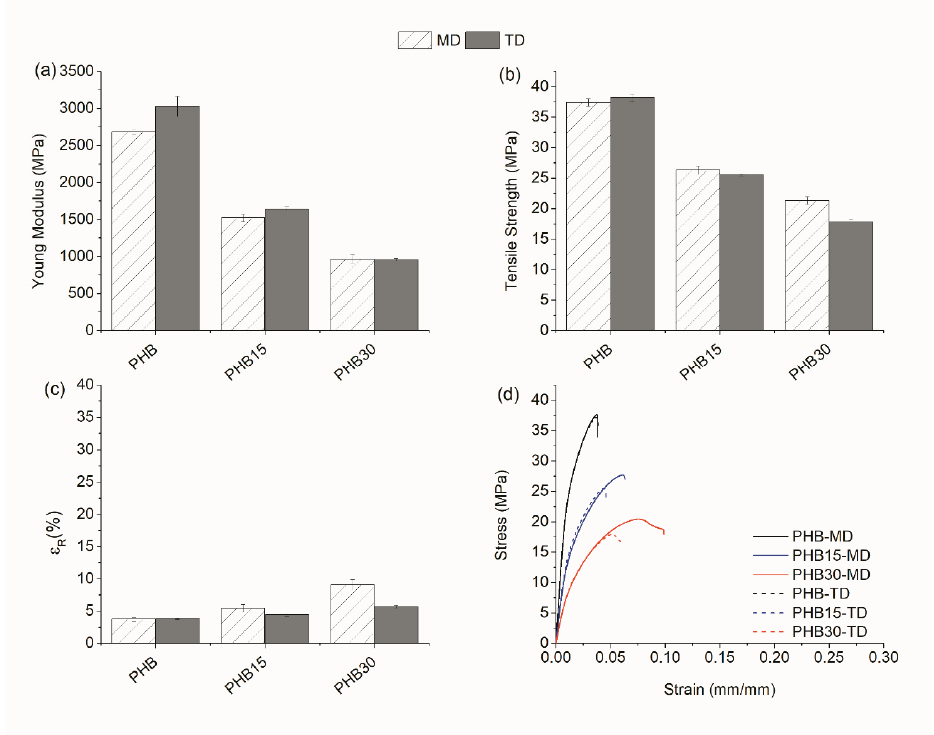
Figure 8. Mechanical properties at 15 days in MD and TD: ( a ) Modulus of elasticity, ( b ) tensile strength, ( c ) strain at break, and ( d ) representative stress vs. strain curves.